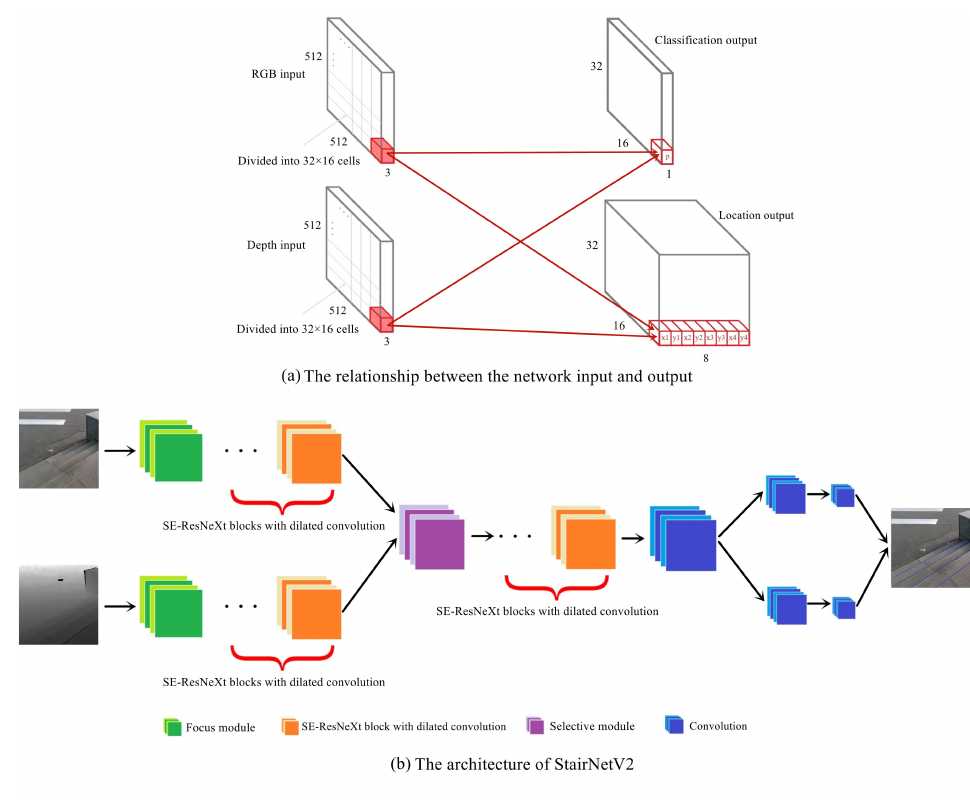
Figure 2. The network architecture of StairNetV2. ( a ) shows that the network has RGB and depth inputs and classification and location outputs. After five downsampling operations, the input size 512 × 512 is transferred to the output size 32 × 16. ( b ) shows the architecture of StairNetV2. Different from some existing methods of fusing RGB feature maps and depth feature maps through simple summation and concatenation, we apply the softmax function to explore the complementary relationship between the RGB stream and the depth